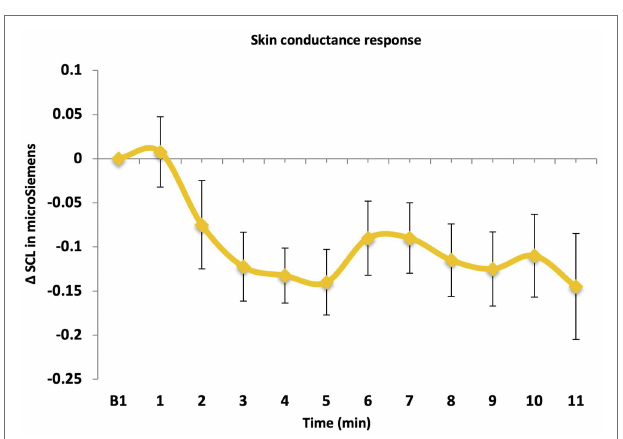
FIGURE 5 | Change in social connectedness (pre to post).